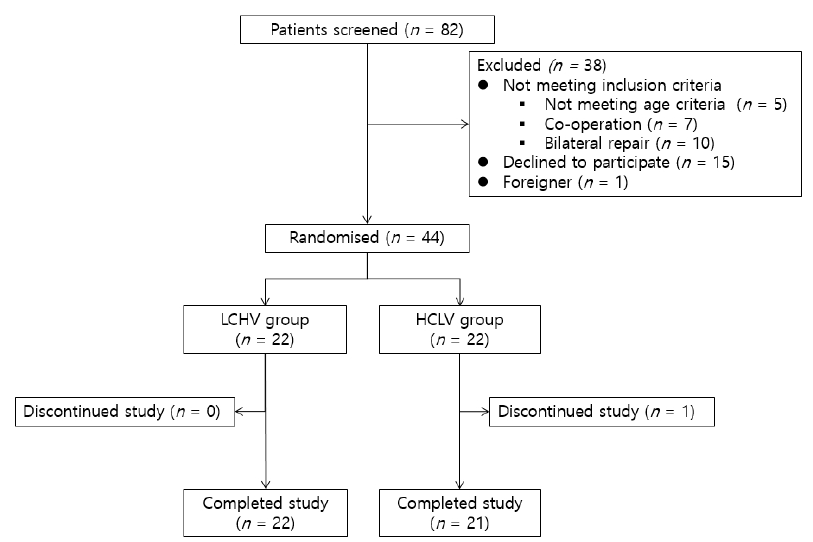
Figure 1. Consort Diagram of the study. LCHV, Low-concentration high-volume; HCLV, high-concentration low-volume.